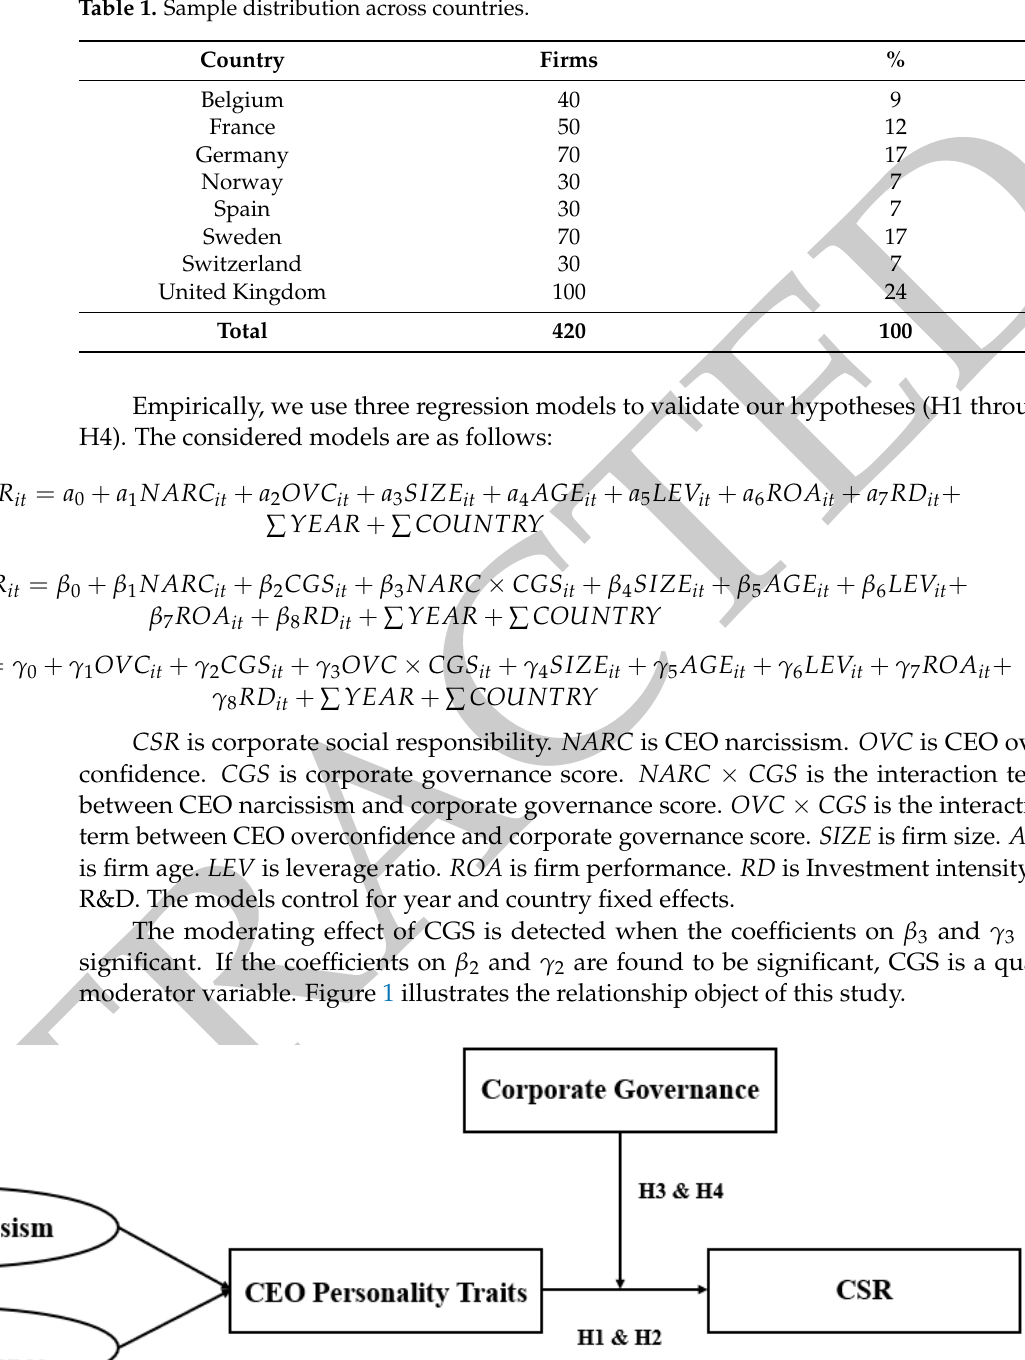
Figure 1. Research model.